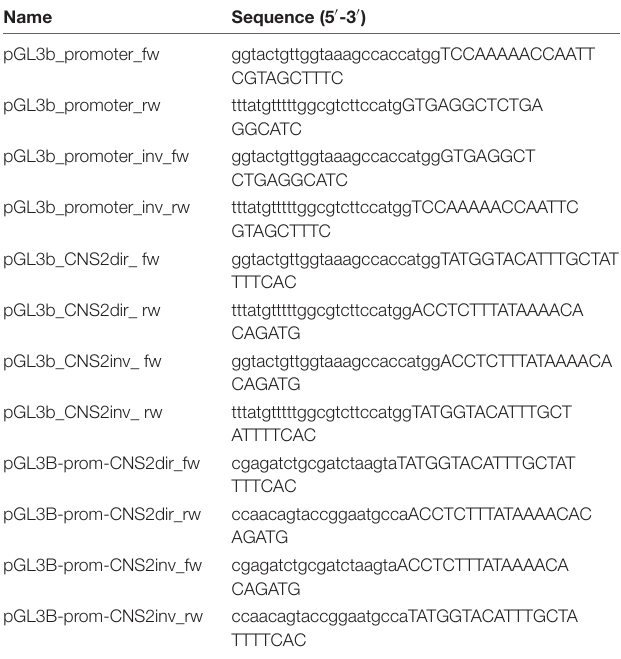
TABLE 1 | PCR primers used for CD69 promoter or CNS2 insertion into pGL3b plasmid using Gibon Assembly Master